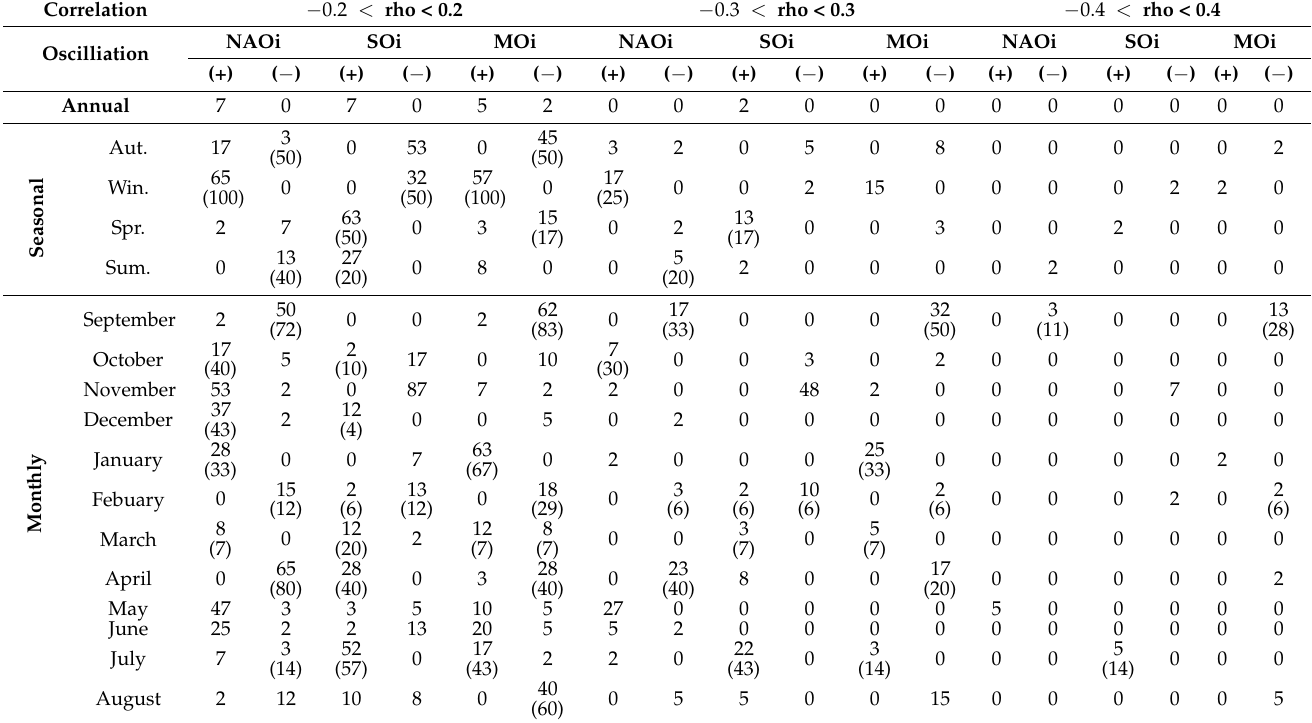
Table 2. Percentage of stations having positive (+) or negative ( − ) correlation (rho) with NAOi, SOi and MOi. Numbers between brackets represent percentage of rainfall series presenting a significant trend which are correlated with climatic